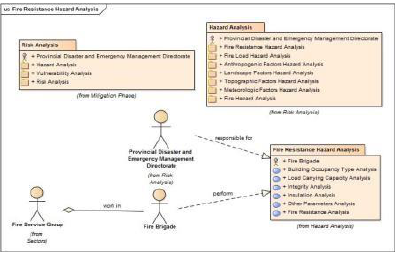
Figure 6: “Fire resistance hazard analysis” activity